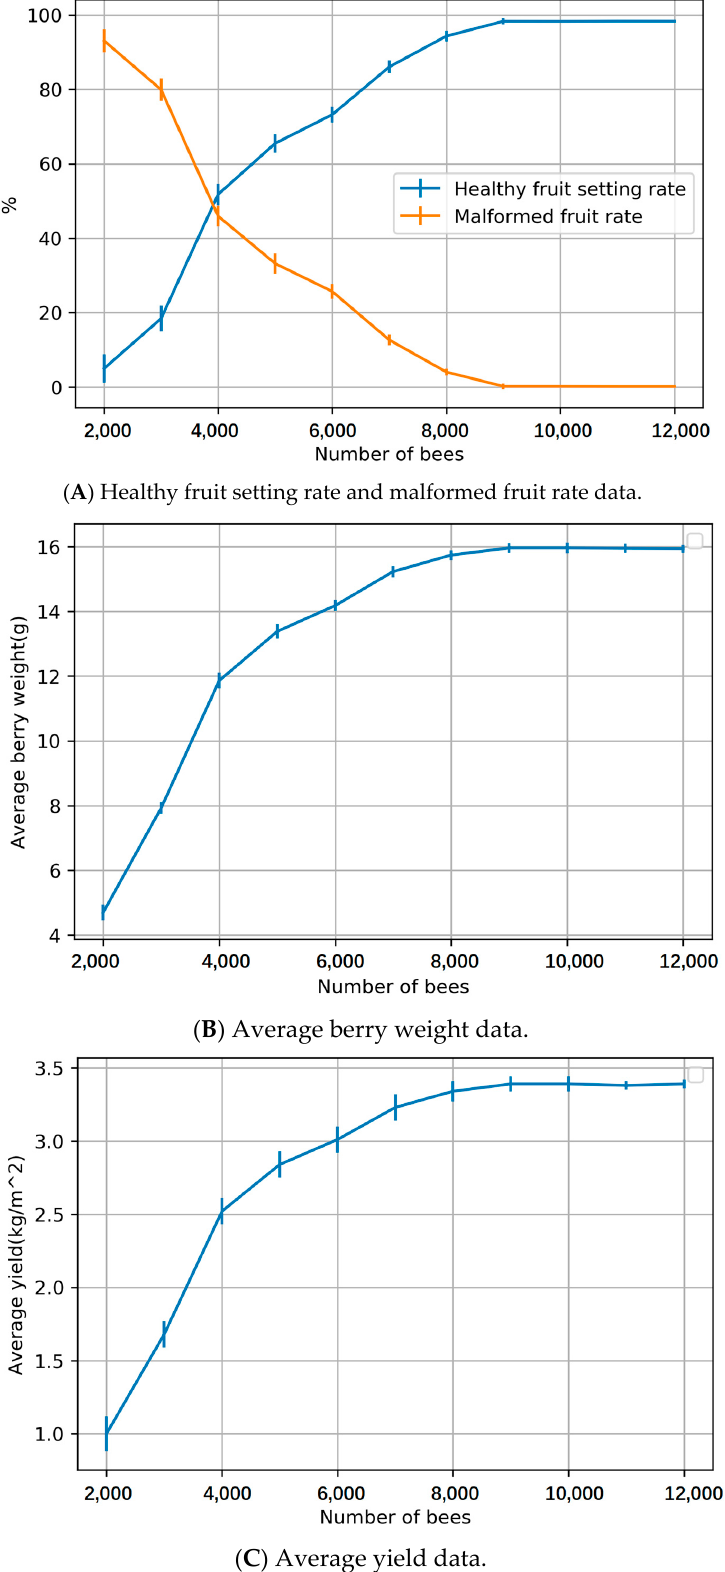
Figure 4. Fruit quality correlated positively with the bee density in simulation.